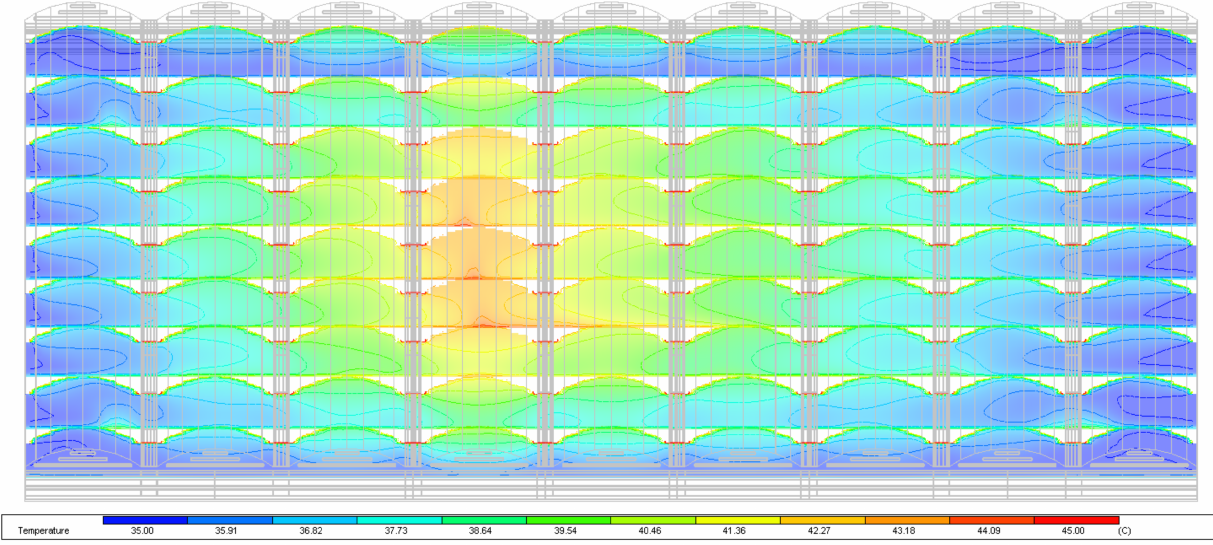
Figure 12. Temperature cloud map of the multi-span round-arch greenhouse (with an in-greenhouse ventilation channel) (outdoor wind speed 0 m/s, outdoor temperature 35 ◦